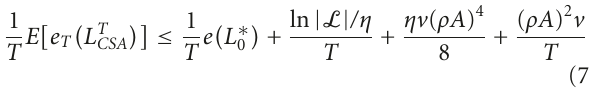
are used to generate nv